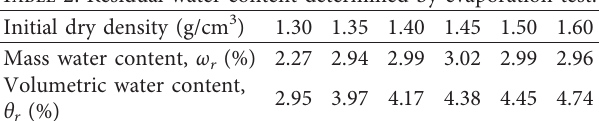
Figure 2: Measured values of SWCCs of Hunan clay with different initial dry